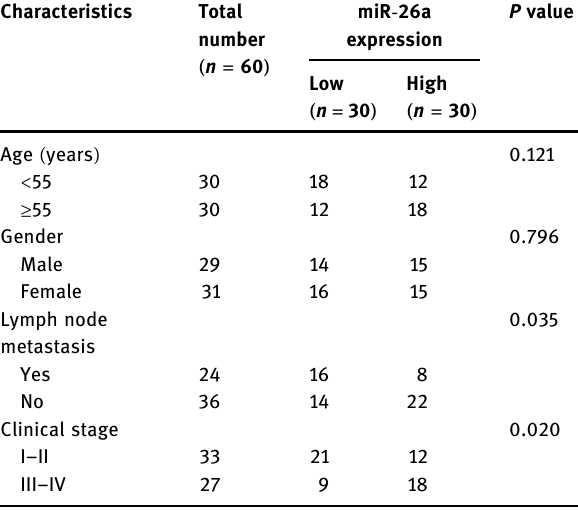
Table 2: Association between miR - 26a expression and clinico - pathological features of ESCC